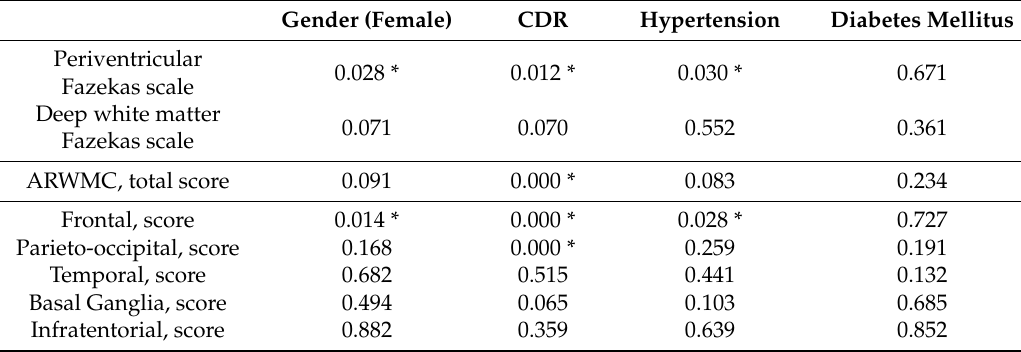
Table 4. Factors related to white matter changes in Alzheimer’s disease